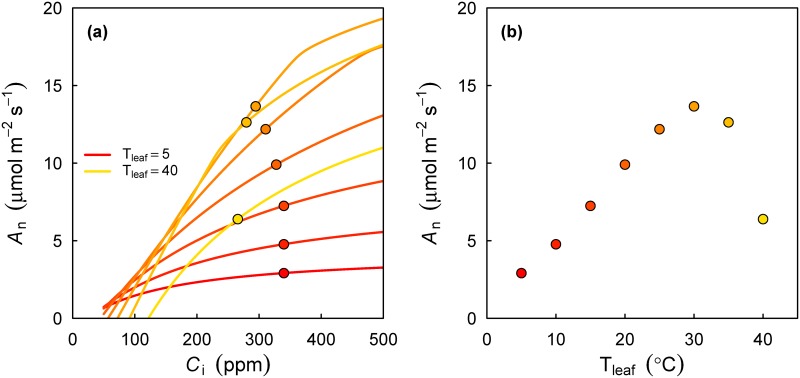
Response of An and Ci to combined changes in Tleaf and D.(A) Lines are A-Ci curves simulated at a range of values for Tleaf. Symbols are the solutions of the coupled leaf gas exchange model, while also taking into account the correlation between D and Tleaf (based on an empirical relationship [35]: D = 0.000605*Tair
2.39). Note that as Tleaf and D increase, Ci decreases. (B) The corresponding temperature optimum of An. Symbols are the same as in panel (A) but plotted against Tleaf.